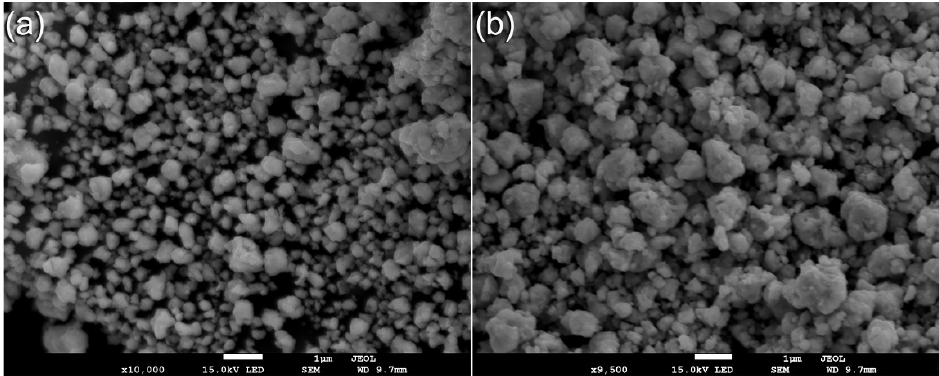
Figure 11. Field-emission scanning electron microscope (FE-SEM) micrograph of as-arc-melt buttons that were high-energy ball milled for 50 h of MD time for ( a ) Cu 50 Ti 40 Ni 10 and ( b ) Cu 50 Zr 40 Ni 10 powders.